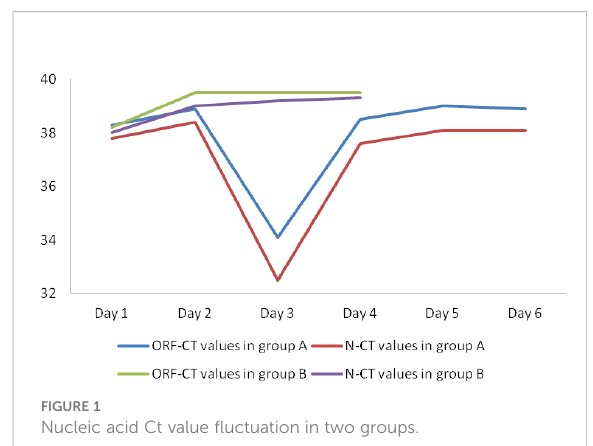
FIGURE 1 Nucleic acid Ct value fl uctuation in two groups.